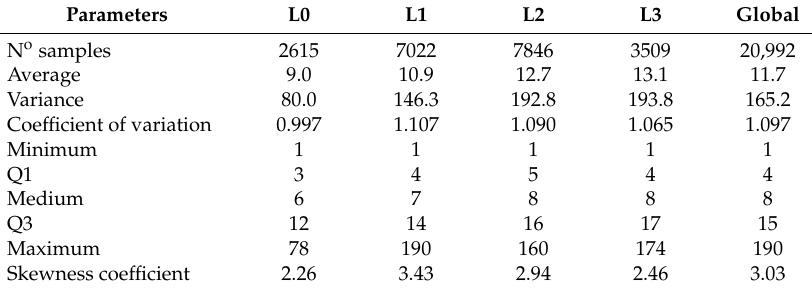
Table A4. Borehole vein thickness